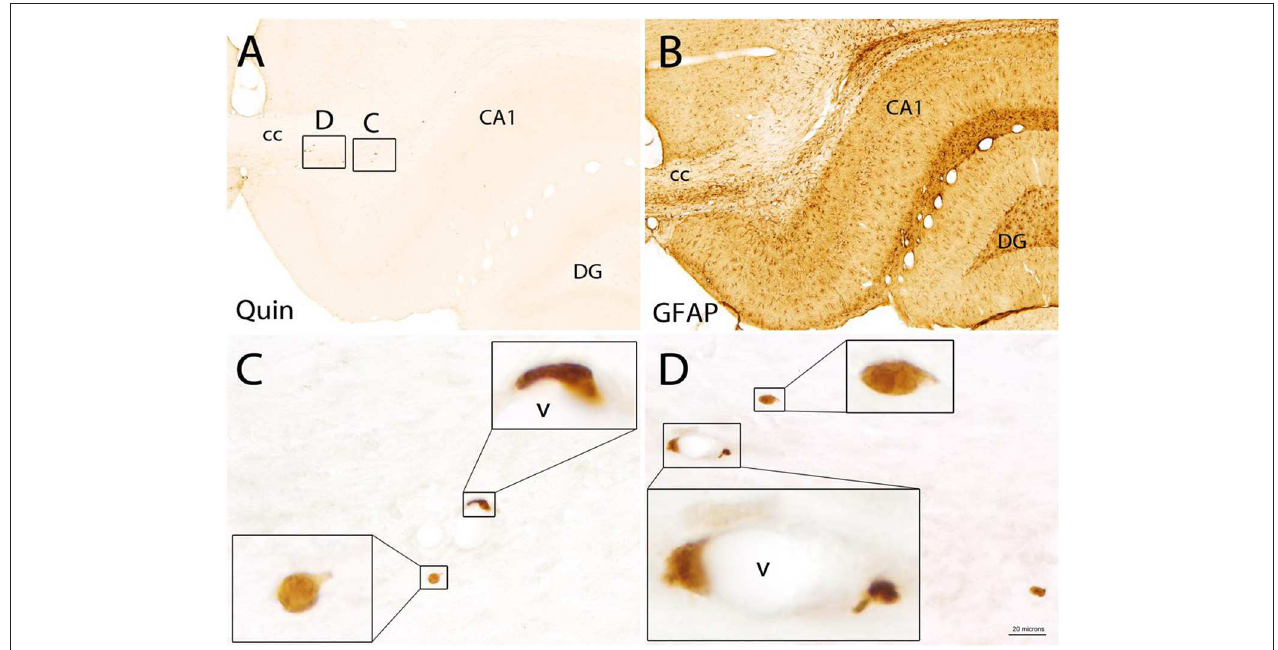
FIGURE 10 | Quin-IR cells in the brain 30 days after LPS injection into the hippocampus. Quin-IR cells were rare near the injection site 30 days after LPS injection (A) and were mostly associated with the vasculature (v). GFAP staining in a tissue section adjacent to that in (A) is shown in (B) . GFAP remained elevated around the injection site at 30 days. The Quin-IR cells exhibited many forms of membrane extension suggestive of diapedesis or migration through tissue (C,D) . CA1, area CA1 of hippocampus, cc = corpus callosum, DG = dentate gyrus of hippocampus. Bar in (D) , 200 µ m in (A,B) , 20 µ m in (C,D) , and 6 µ m in panel